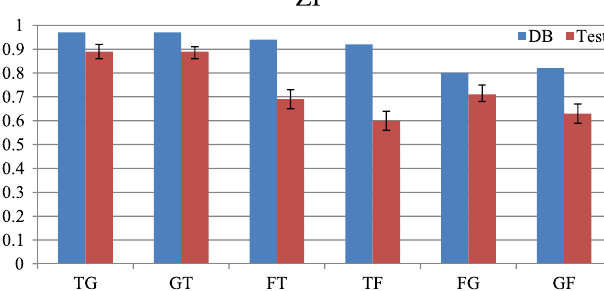
FIG. 9. Comparison of the data from De Bock, Van Dooren, and Verschaffel [15] (DB) and our data (Test) for the ZP function type for each of the representational transitions.